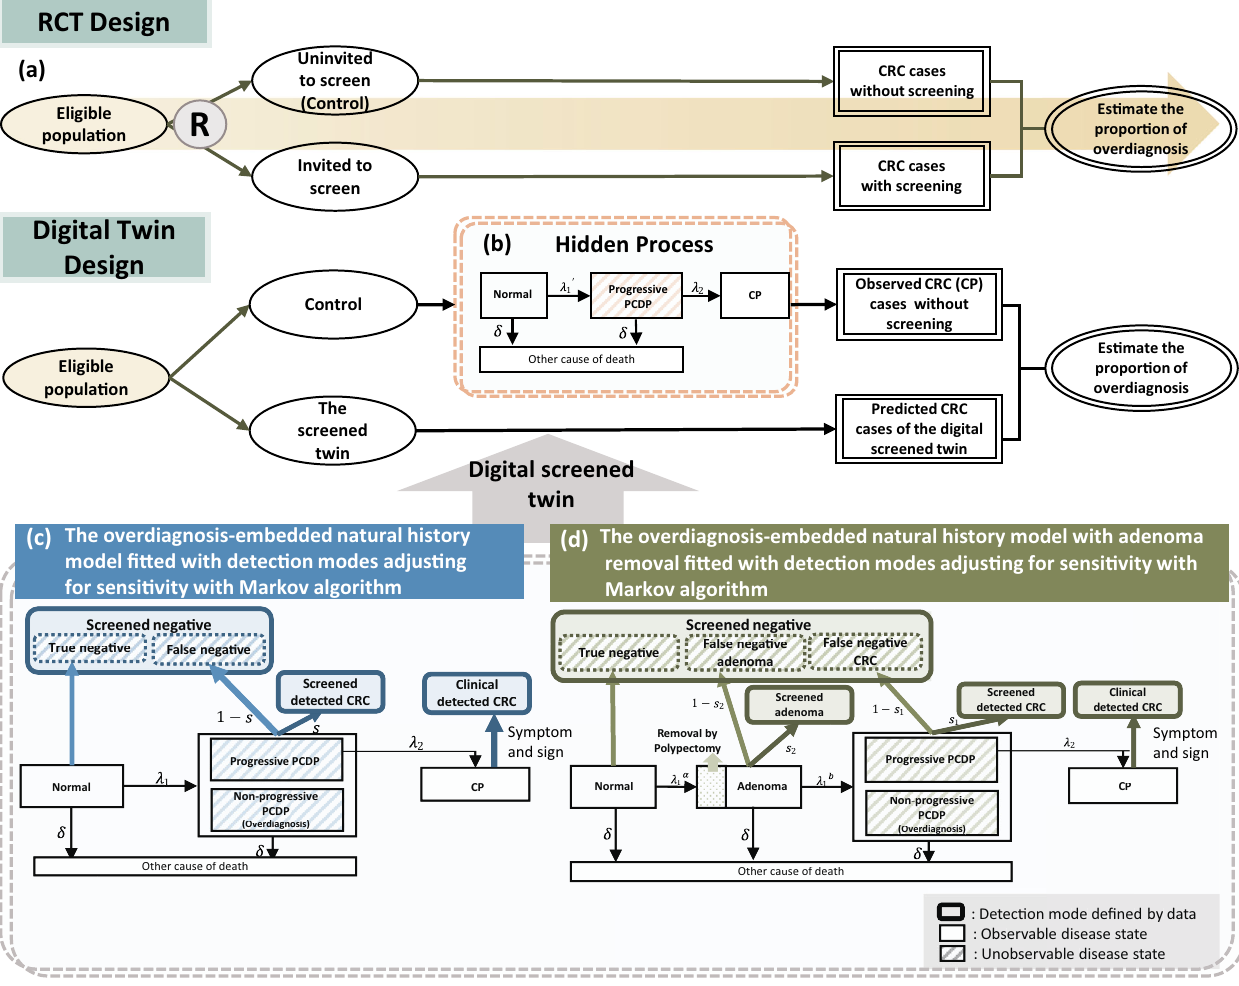
Fig. 1 Randomized controlled trial (RCT) and digital twin design for overdiagnosis in population-based screening. a The design of randomized controlled trial for evaluation of overdiagnosis; b the hidden disease natural history process from normal, PCDP, until the clinical phase among the control group in the absence of screening; c the overdiagnosis-embedded multi-state Markov model and algorithms for learning parameters with adjustment for sensitivity and competing mortality from the screened group; d the overdiagnosis-embedded multi- state Markov model and algorithms with adenoma for learning parameters with adjustment for sensitivity and competing mortality from the screened